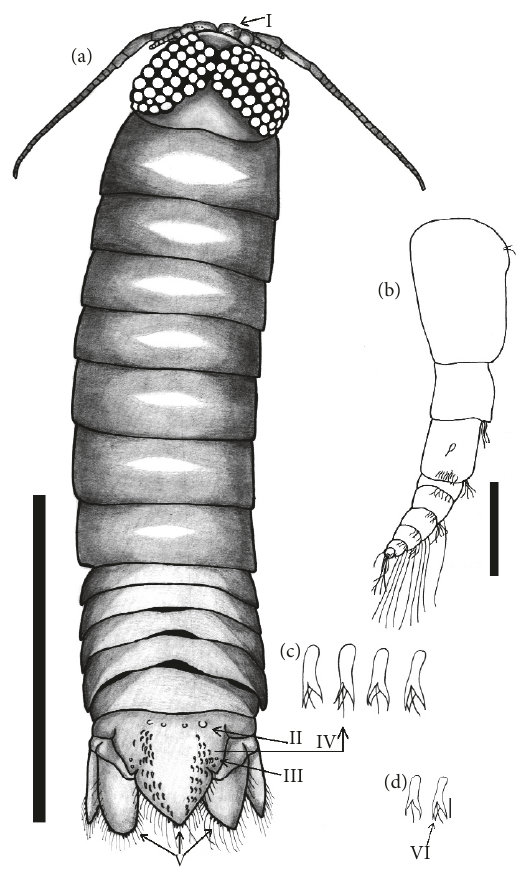
Figure 4: Excorallana richardsoni collected from Lutjanus jocu , dorsal view. Bar: 2 mm; (b) Antenna I. Bar: 0.2 mm; (c) Detail of the bristles. Arrow I - Swollen basal segment of the first antenna; setae II and III - Tubers of the anterior and lateral pleotelson, respectively; Arrows IV and V - position of the pleotelson bristles and detail of these structures; (d) Comparison between sow bugs described by Menzies and Kruczynski [15] and those described in the present study, arrow points to the bifid end of the sow bug.